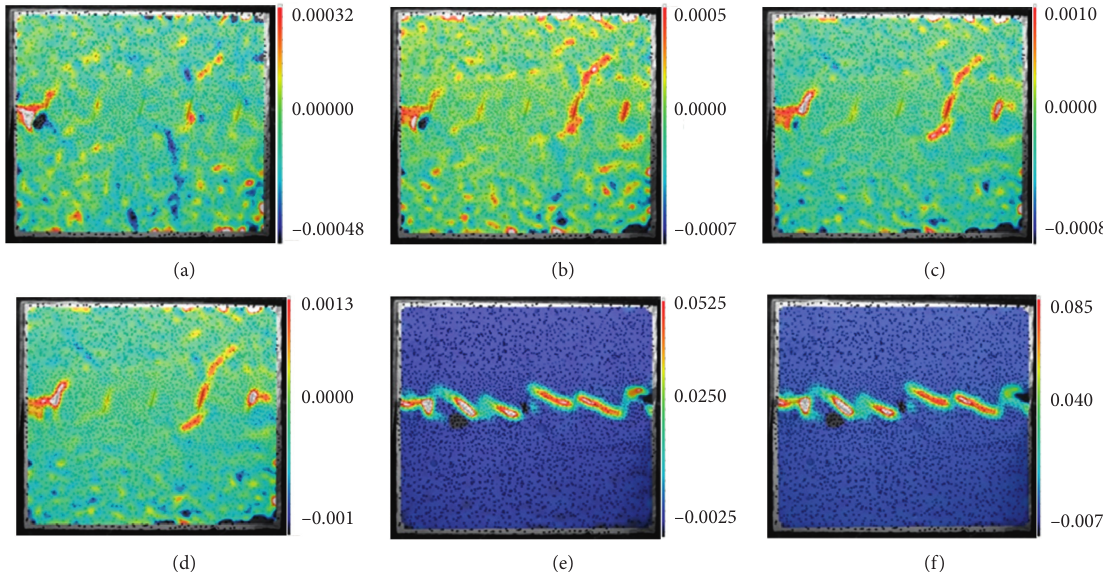
Figure 9: Shear strain evolution of jointed specimens (B-30). (a) Load level of 10%. (b) Load level of 30%. (c) load level of 50%. (d) Load level of 70%. (e) Load level of 90%. (f) Load level of